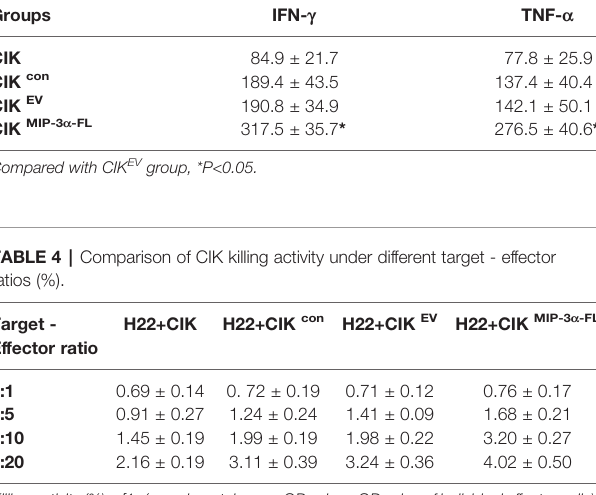
TABLE 1 | Comparison of CIK cell proliferation at different time points (%).